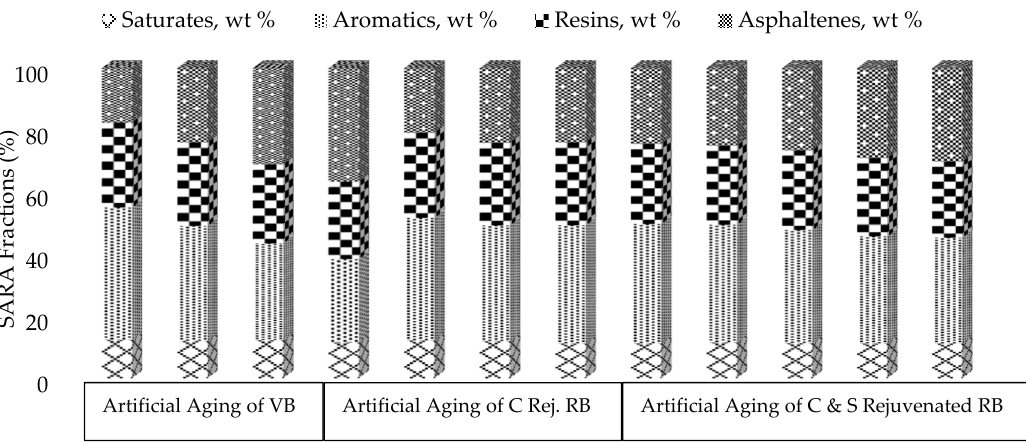
Figure 3. Effect of rejuvenation and aging on saturates, aromatics, resins, and asphaltene (SARA) fractions of binder.